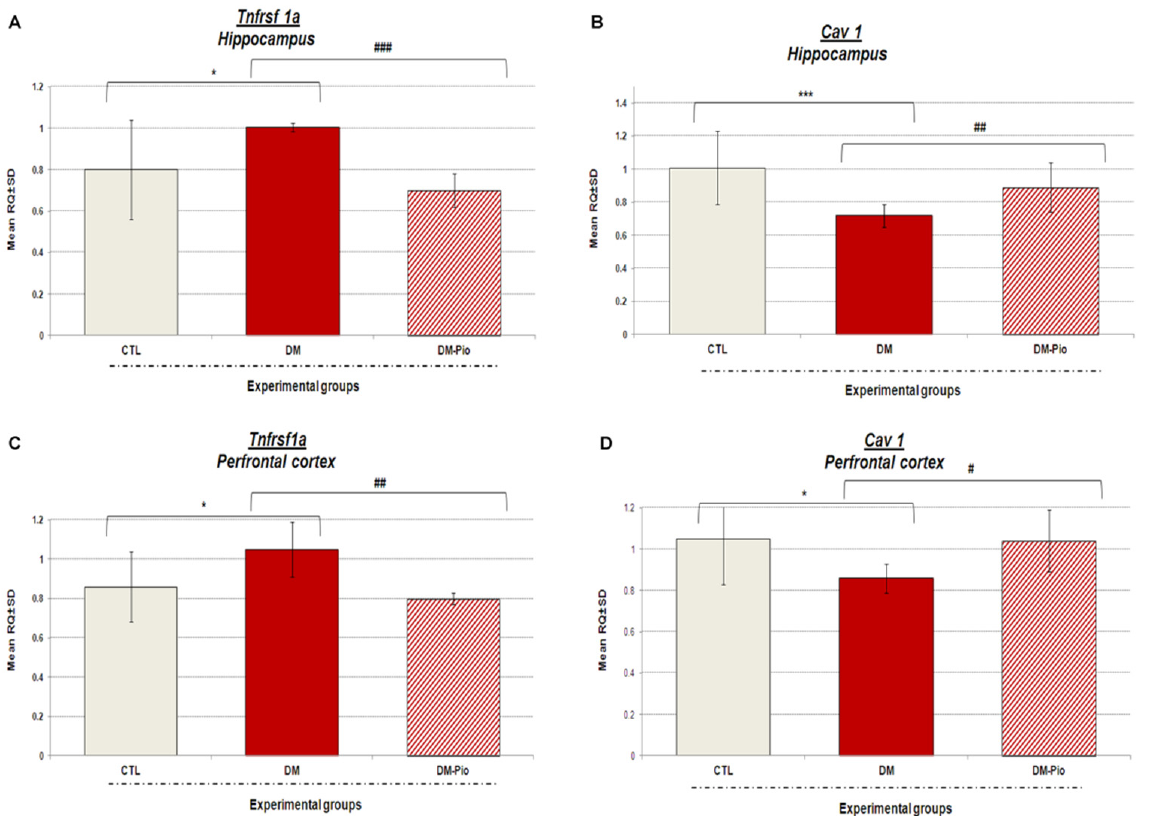
Figure 5. Expression of mRNA levels of Tnfrsf1a and Cav1 in the hippocampus and prefrontal cortex of diabetic mice after 2 weeks treatment with pioglitazone. The bar height represents the mean ± SD for Tnfrsf1a and Cav1 gene expression in individual experimental groups: CTL: non-diabetic mice, DM: diabetic mice, DM-Pio: pioglitazone-treated mice [30 mg/kg, po ] in the hippocampus ( A , C ) or prefrontal cortex ( B , D ) of mice. One-way ANOVA, followed by Tukey’s post hoc test was used. * p < 0.05; *** p < 0.001 in comparison with control group. # p < 0.05; ## p < 0.01; ### p < 0.001 in comparison with diabetes group.